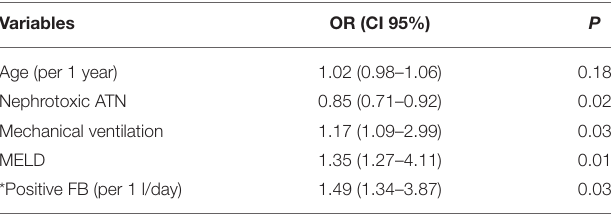
TABLE 5 | Association (with p < 0.25) between multiple adjusted patient and peritoneal dialysis characteristics and